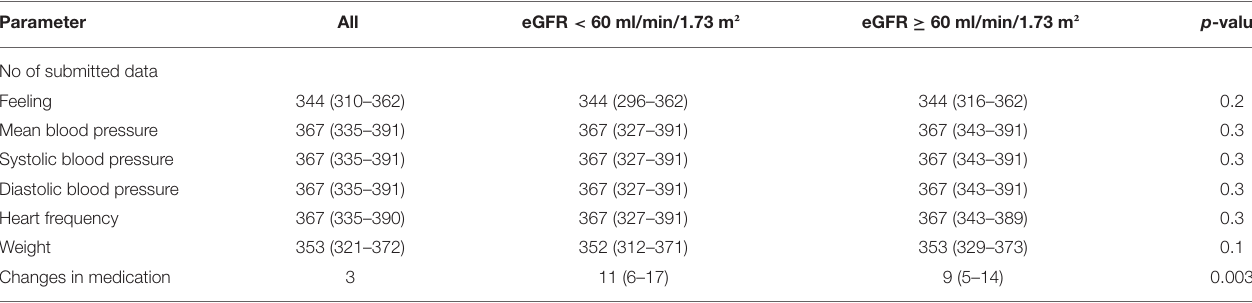
TABLE 6 | Measurements in remote patient management and changes in medication in patients with normal and impaired renal function. Parameter All eGFR < 60 ml/min/1.73 m ²